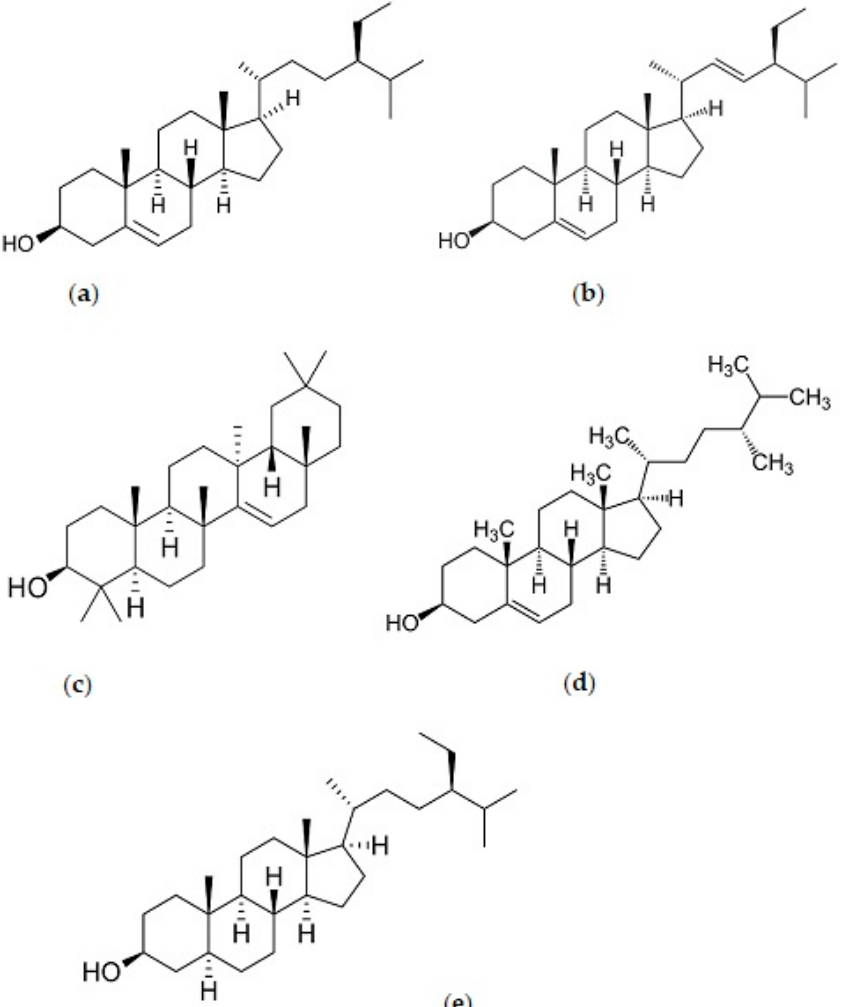
Figure 1. Phytosterols in C. ternatea flower: ( a ) β -sitostrerol; ( b ) stigmasterol; ( c ) taxaxerol; ( d ) campesterol; ( e ) sitostanol.